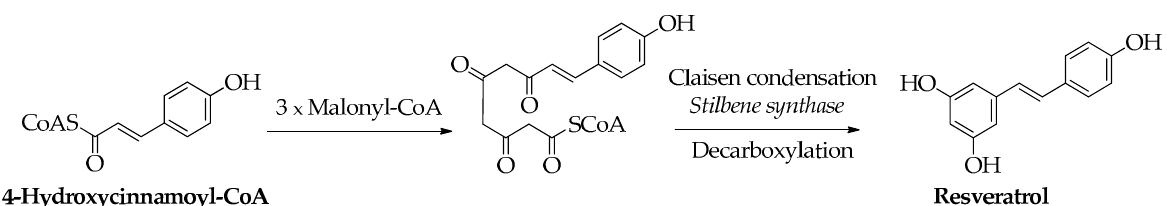
Scheme 1. Biosynthesis of resveratrol.